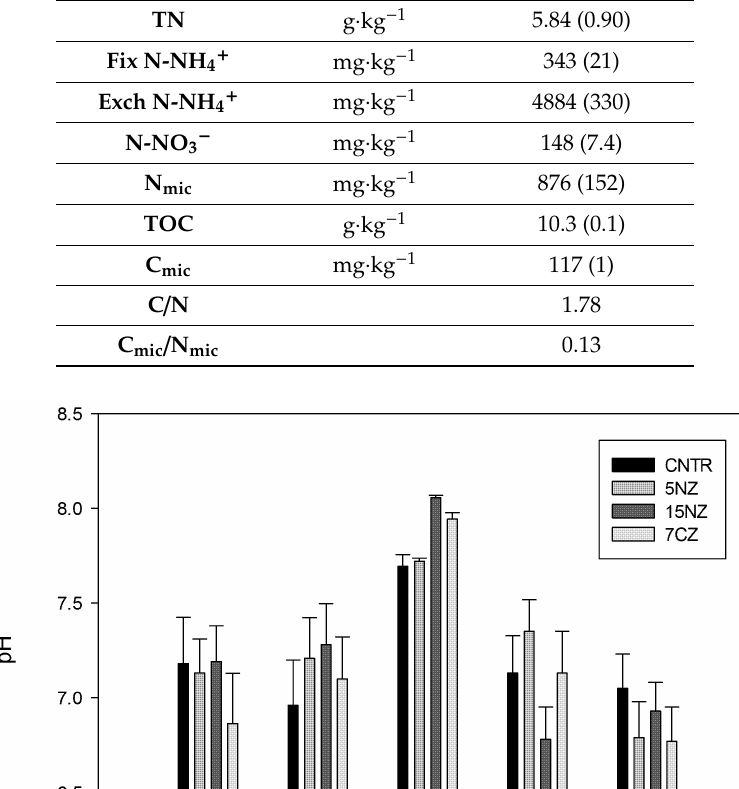
Table 1. Average N and C pools of NH 4+ -enriched zeolitite (NEZ). Standard deviation within brackets.